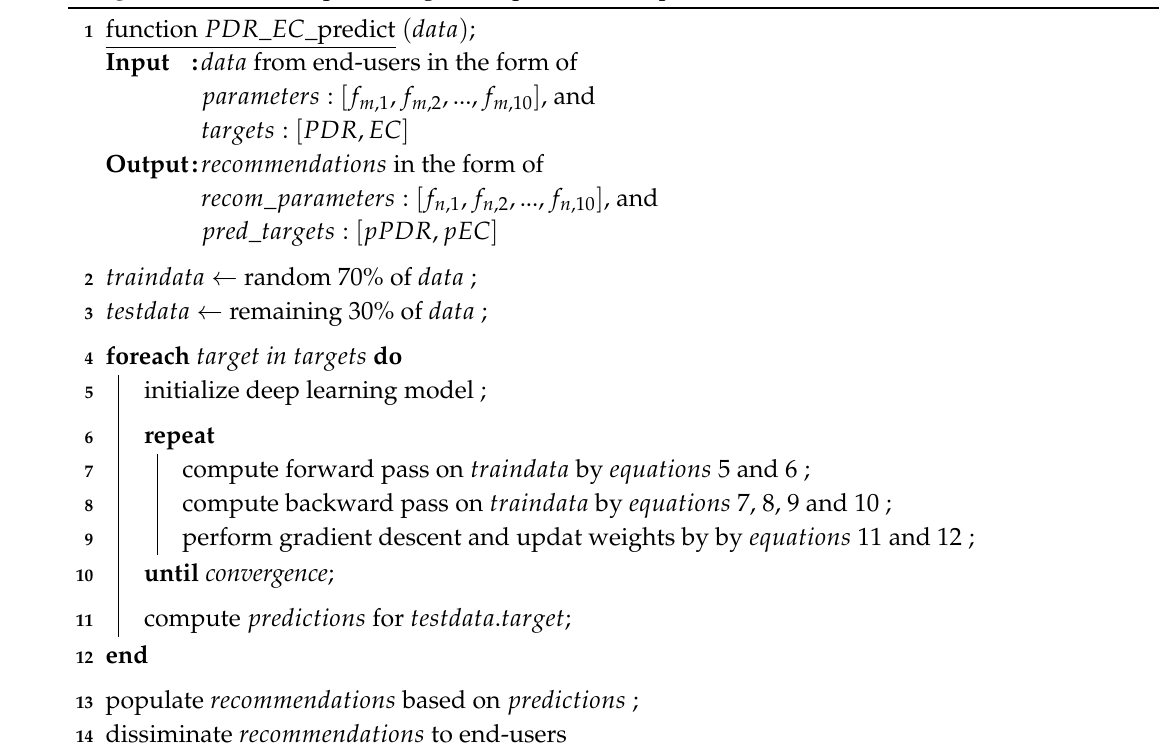
Algorithm 1: The deep learning based procedure to predict PDR and